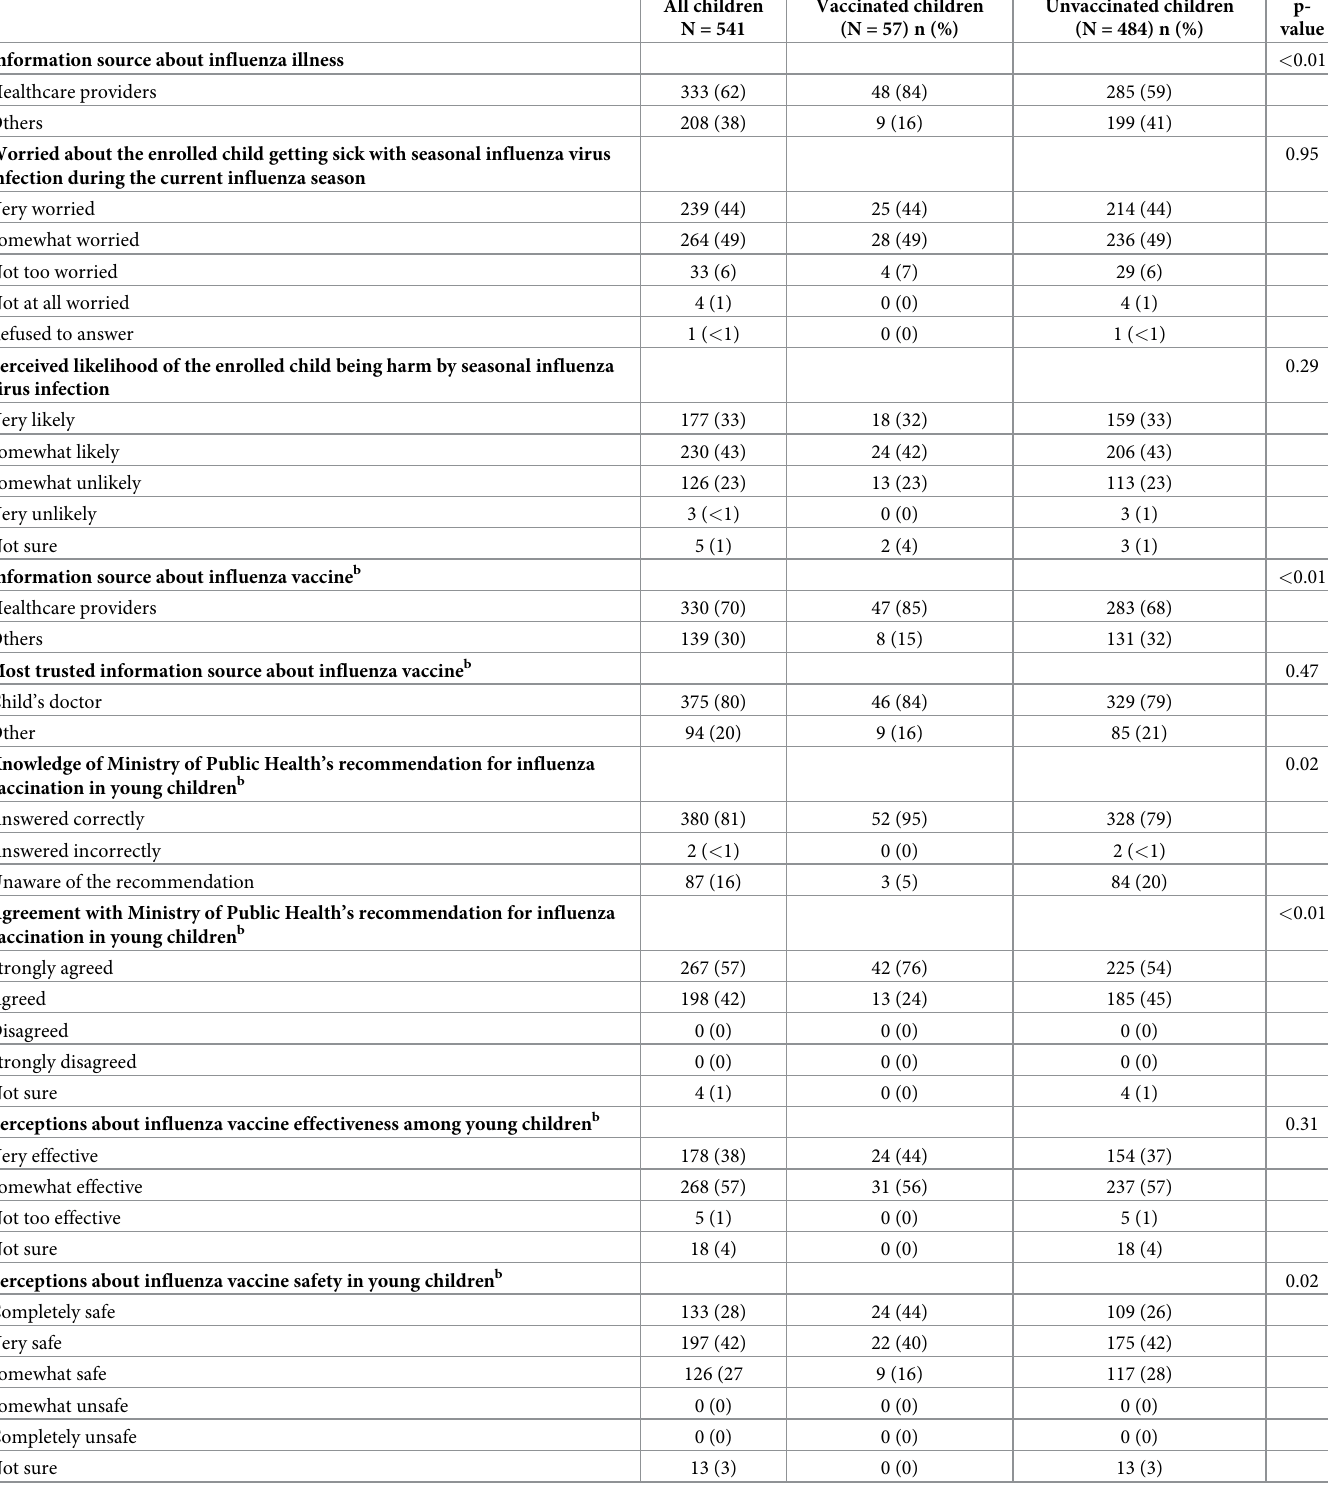
Table 2. Respondents’ information source, knowledge, attitude/perception toward influenza illness and influenza vaccine in the 2018 influenza season in children aged six months to two years a